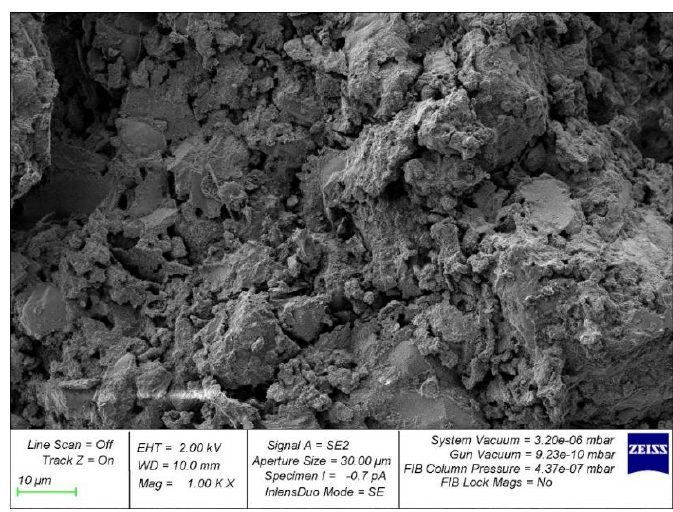
Figure 12. Sample with partial replacement of cement with eggshell powder at 20%.